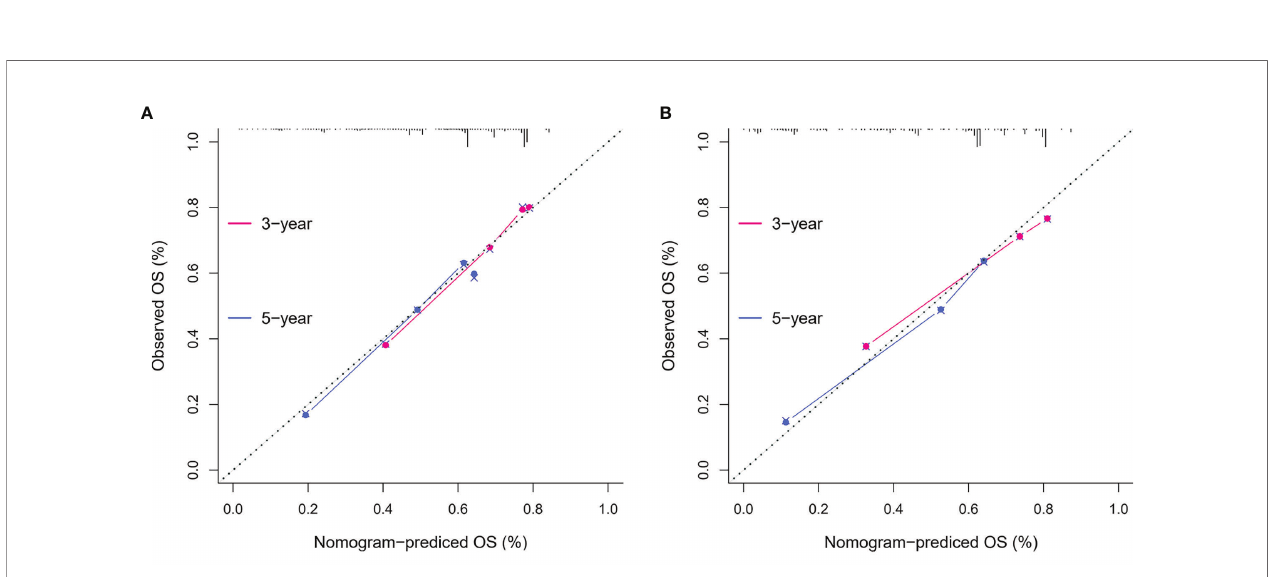
FIGURE 7 | Nomogram for predicting prognosis in lymph node positive CRC. The nomogram was developed in the primary cohort, with the TNM stage, CRP/MCV ratio, and differentiation incorporated.